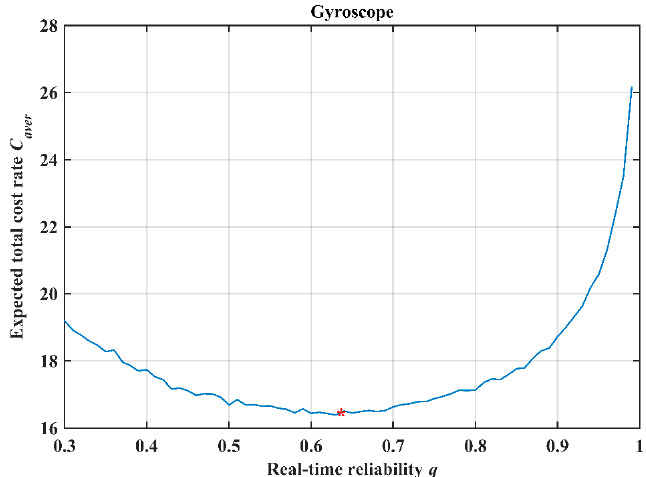
Figure 5. Total expected cost rate C aver versus the real-time reliability threshold q when w 0 = 0.58 ( ◦ /h )